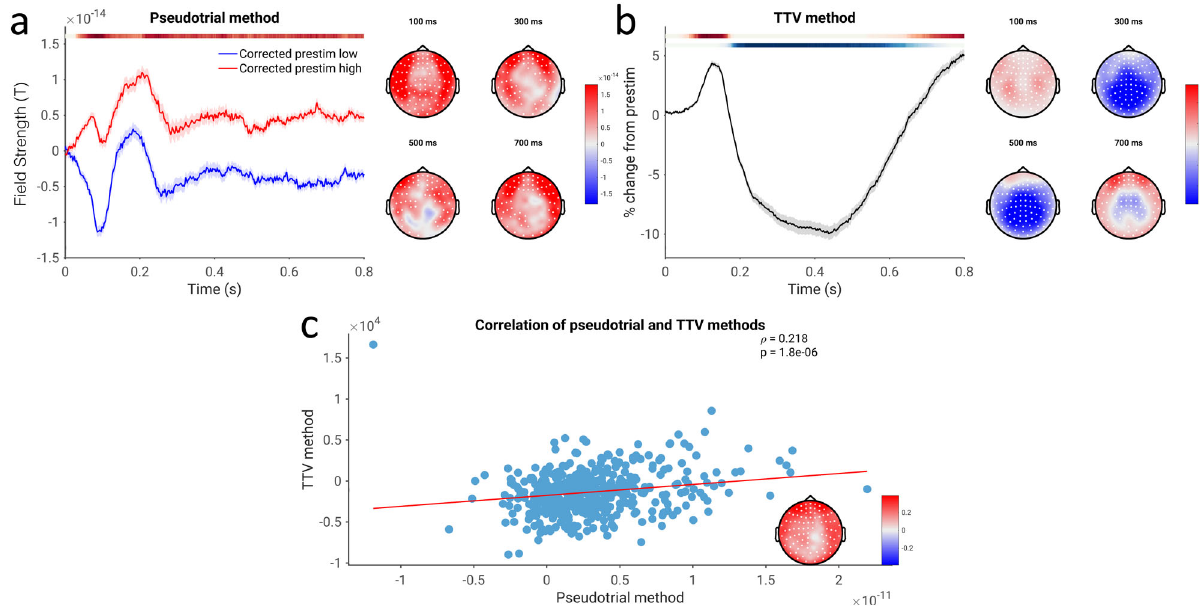
Fig. 3 Time-domain correlation of spontaneous and evoked magnetic fi eld strength, assessed using both methodologies in the CamCAN dataset. a Pseudotrial-corrected time courses for high prestimulus (red) and low prestimulus (blue) conditions. Line shows mean across all sensors and subjects, shaded area indicates standard error of the channel-average time course across subjects. Effect topographies are shown at 100 ms, 300 ms, 500 ms, and 700 ms; white dots indicate sensors which are part of a signi fi cant cluster. Shaded overbars indicate the signi fi cance of the difference between prestim high and low conditions. The shade of the bar indicates the percent of sensors which are part of a signi fi cant cluster at any given time point (i.e., darkest = all sensors part of cluster, lightest/white = no sensors part of cluster); red indicates positive clusters (prestim high > prestim low), blue indicates negative clusters. b Lines, overbars, and topographies as in a : red overbars indicate clusters with TTV increases, blue overbars indicate TTV decreases. c Correlation between the methodologies. Channel-average values of the summary index are plotted in the scatterplot, and the correlation coef fi cient at each electrode is plotted in the inset. White dots indicate sensors signi fi cant after cluster correction. N = 474